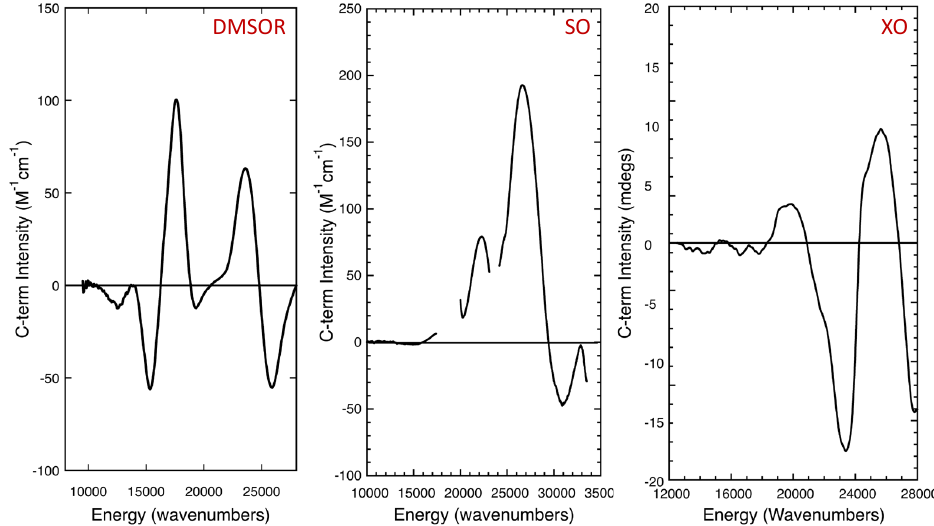
Figure 7. MCD spectra of DMSO reductase [23], sulfite oxidase [147], and xanthine oxidase [106] . Left : DMSOR “high ‐ g split” collected under turnover conditions using TMAO as the oxidizing substrate, Middle : Chicken sulfite oxidase with b ‐ heme contribution subtracted. Right : xanthine oxidase “very rapid” species generated using the slow substrate 2 ‐ hydroxy ‐ 6 ‐ methylpurine.